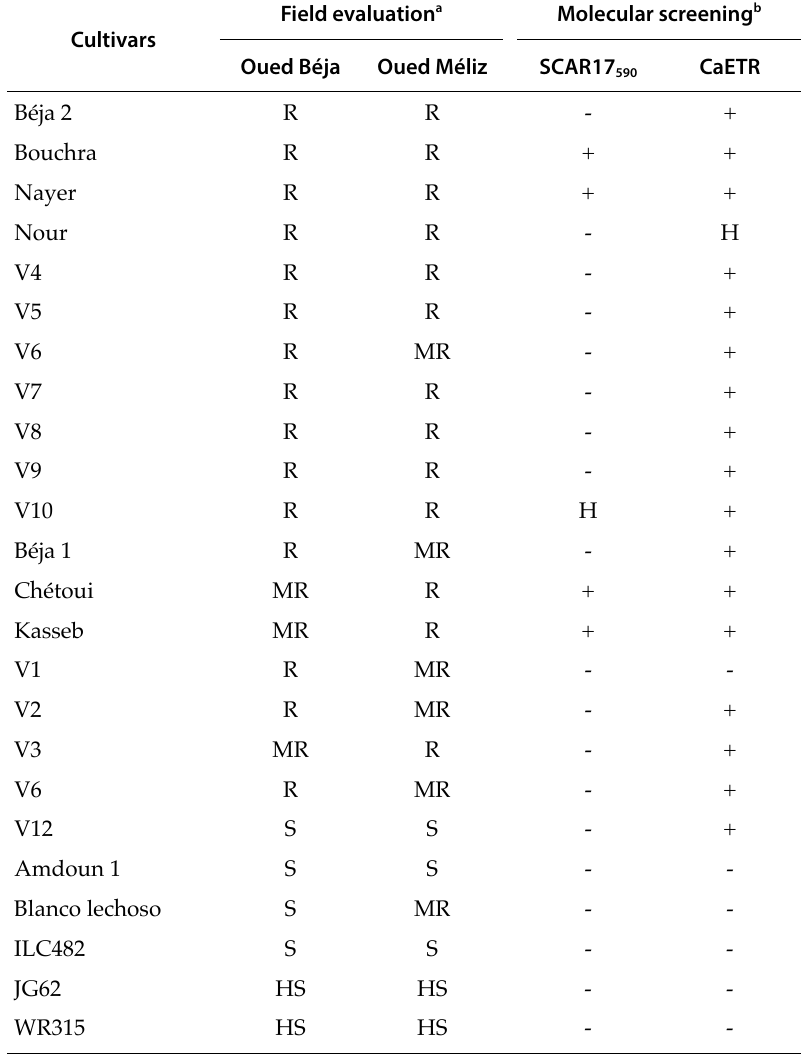
Table 6. Association of resistance and susceptible alleles of two DNA markers, SCY17 susceptible phenotypes of chickpea cultivars evaluated under field